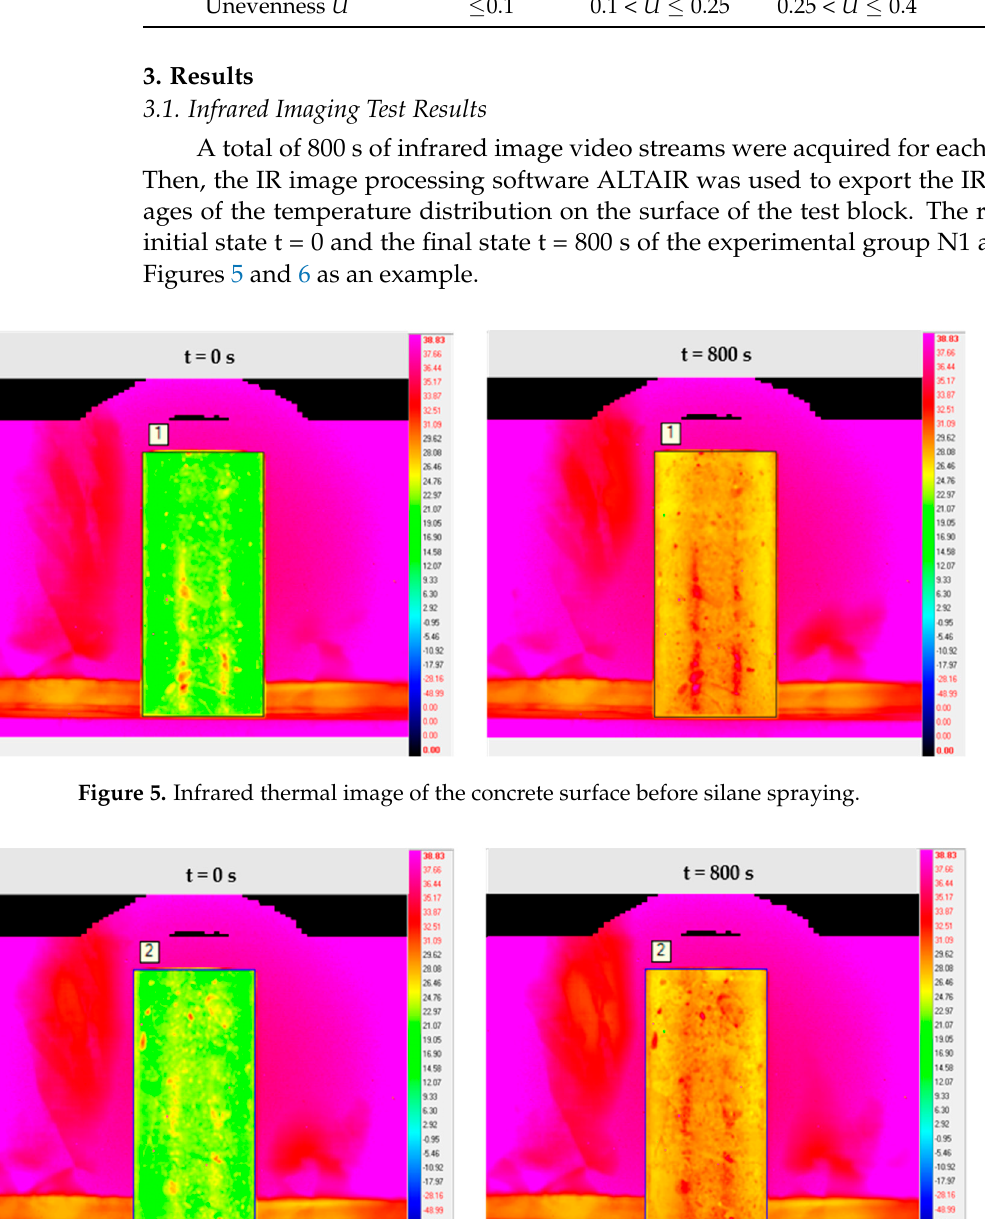
Table 1. Classification of concrete surface coating uniformity grade.